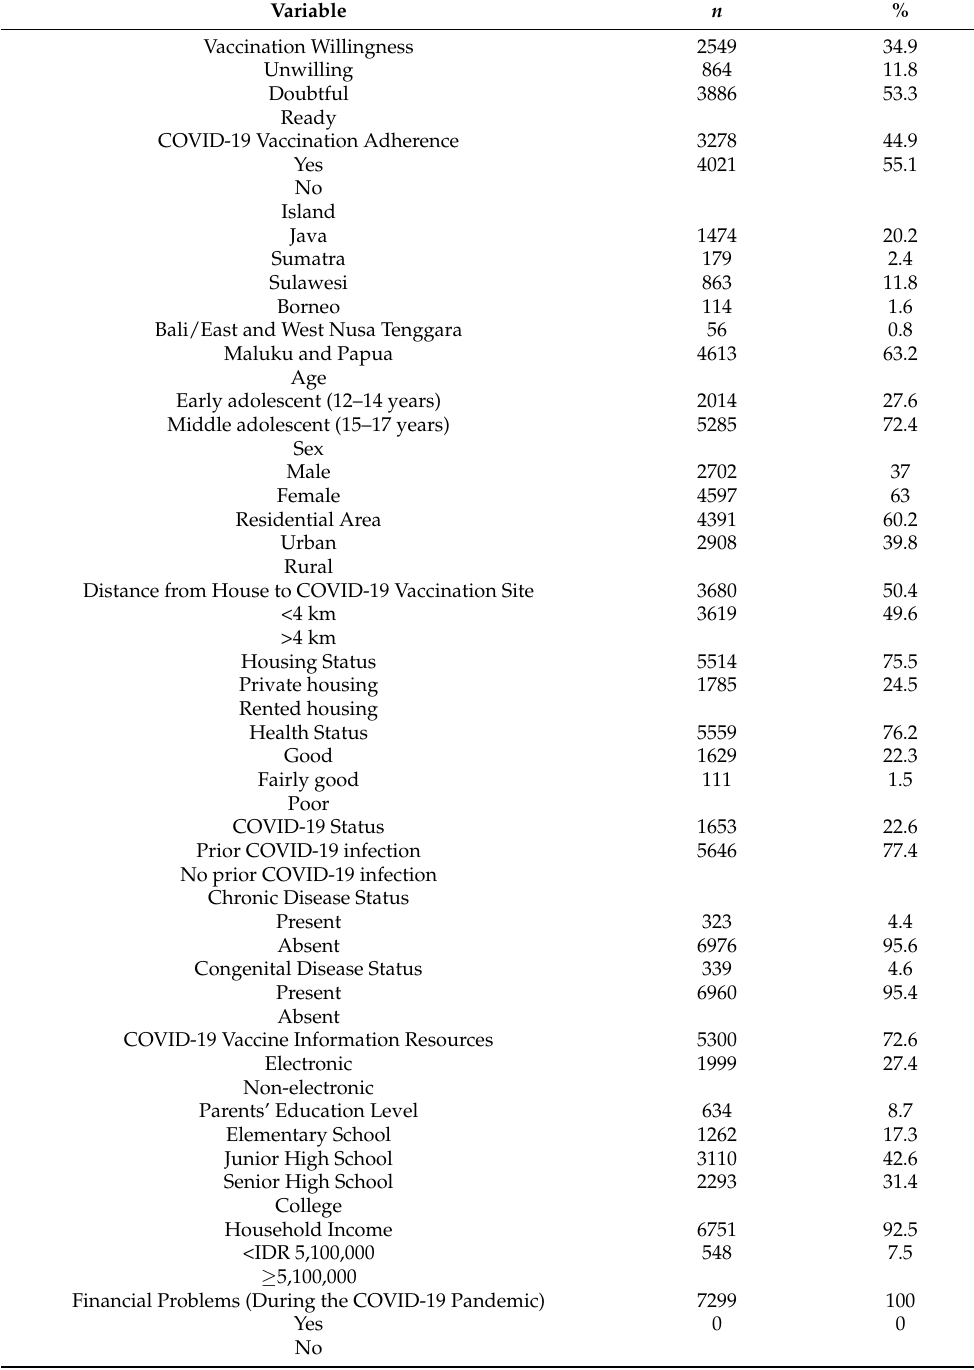
Table 1. Sociodemographic characteristics ( n =